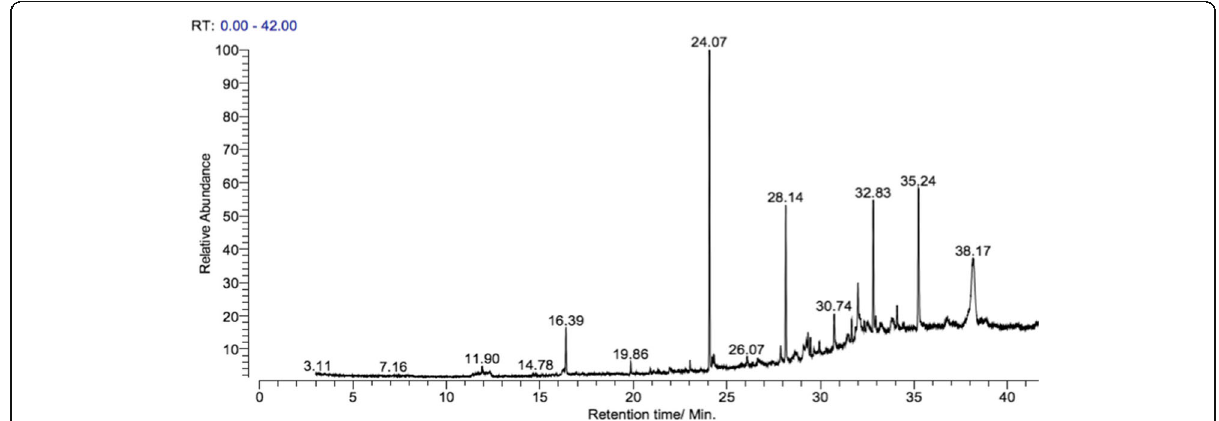
Fig. 5 Gas Chromatography - Mass Spectroscopy (GC-MS) spectrum of ethanol bark extract of Flacourtia